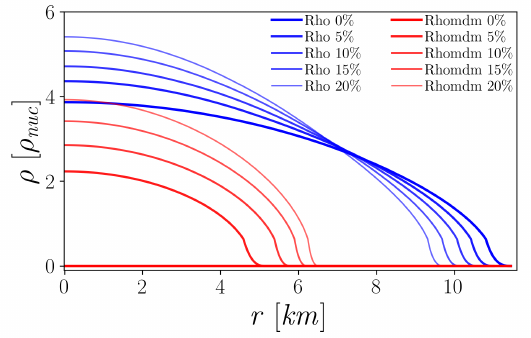
Figure 2. Density profiles of admixed neutron stars with a 0%, 5%, 10%, 15% and 20% mirror dark matter contribution to the total gravitational mass of 1.4 M (cid:12) . Blue lines refer to the baryonic density, while red ones denote the dark matter profiles. It is noticeable that with increasing dark matter content, the star has a more compact equilibrium